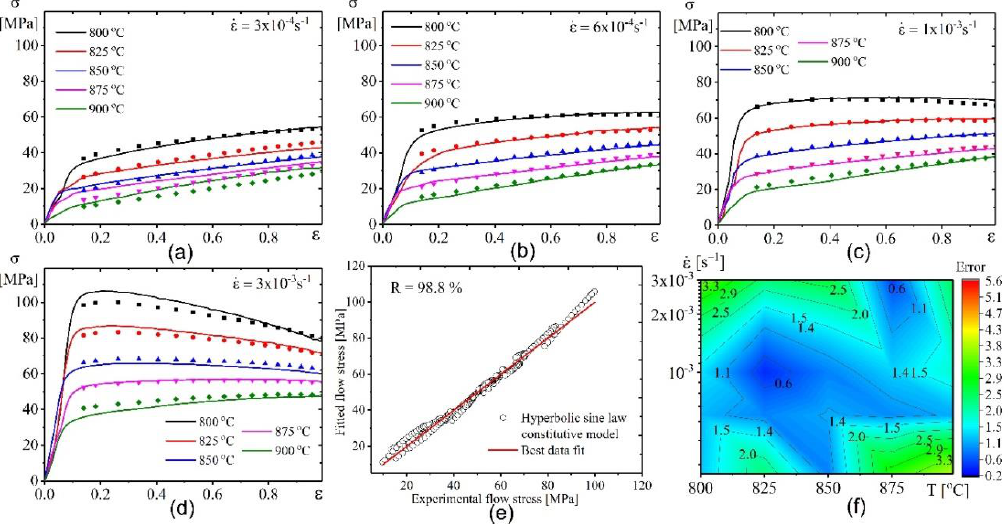
Figure 11. Comparative plots for the experimental results (lines) and fitted values by hyperbolic sine law model (symbols) at ( a ) 4 × 10 −4 s −1 , ( b ) 6 × 10 −4 s −1 , ( c ) 1 × 10 −3 s −1 , and ( d ) 3× 10 −3 s −1 ; ( e ) the correlation between experimental and fitted flow stress; ( f ) the error between experimental and tested flow stress.